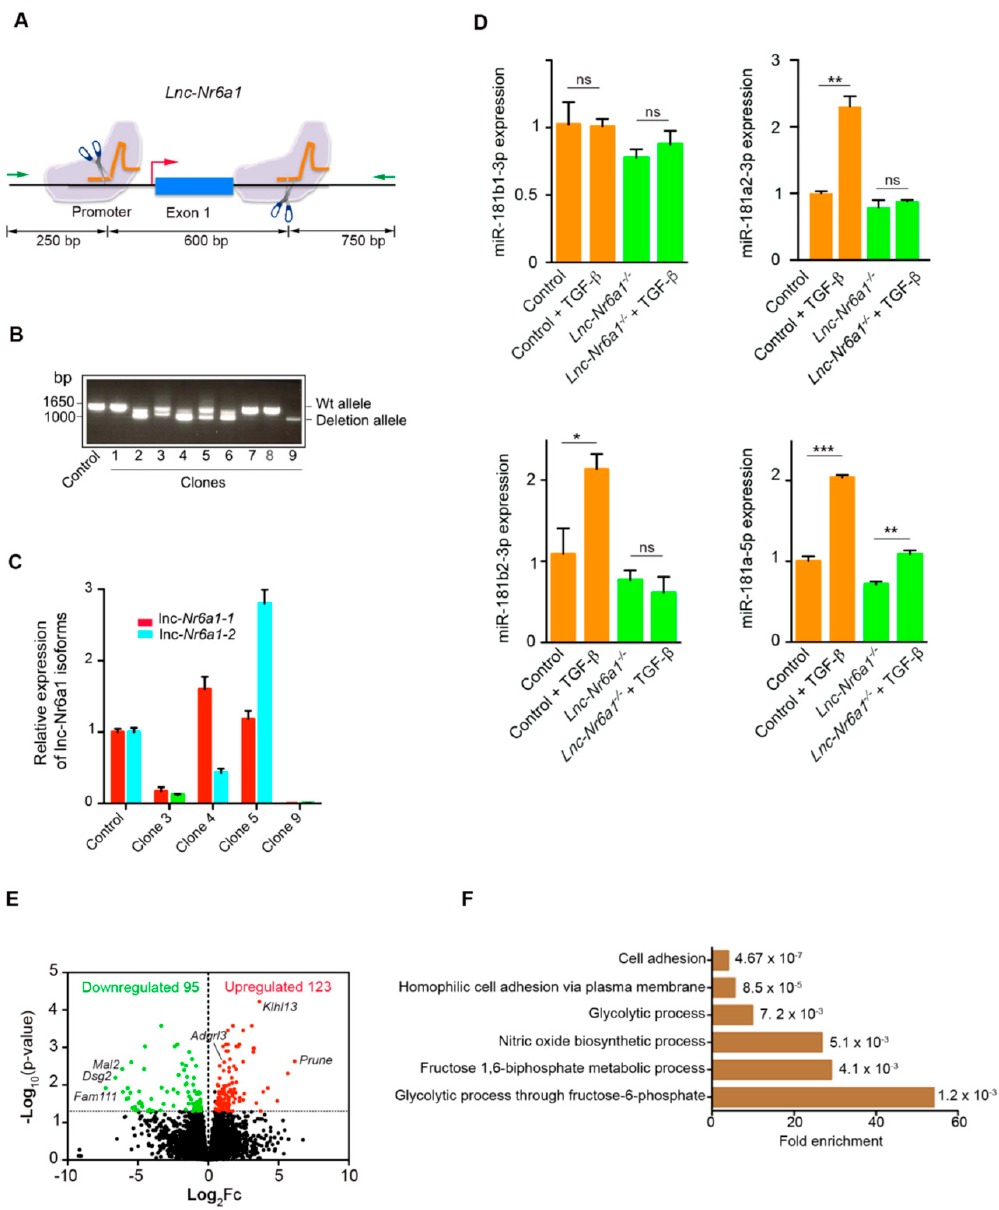
Figure 3. Deletion of a Lnc-Nr6a1 fragment in NMuMG cells and expression profile. ( A ) Scheme showing the 600 bp deleted fragment of Lnc-Nr6a1 deletion in NMuMG cells using CRISPR-Cas9 technology. Sites of cleavage by Cas9 in the promoter and first exon regions are indicated; primers (green arrows) for clones analysis are shown ( B ) Representative gel identifying non-deletion (control, clones 1, 7 and 8) monoallelic (clone 2, 3, 4, 5 and 6) and biallelic clones (clone 9). ( C ) Expression levels of lnc- Nr6a1 isoforms in different clones were measured by RT-qPCR analysis. ( D ) Expression of miR-181a/b species in control and Lnc-Nr6a1 -depleted cells after 24 h of TGF- β treatment or untreated. Experiments were repeated twice in triplicate samples; error bars represent S.D. *** p < 0.001, ** p < 0.01, * p < 0.05, ns, not significant by two-tailed Student’s t -test. Y-axis of last panel (down right) is labeled 181a-5p because the isoforms miR-181a1-5p and miR-181a2-5p are identical. ( E ) Volcano plot for differentially expressed genes in Lnc-Nr6a1 -depleted cells versus control cells. Genes upregulated with more than a 1.5-fold change with a p -value < 0.05 are depicted in red boxes and those downregulated with identical fold change and p -value are in green boxes. ( F ) Gene ontology enrichment analysis of downregulated genes in Lnc-Nr6a1 -depleted cells.